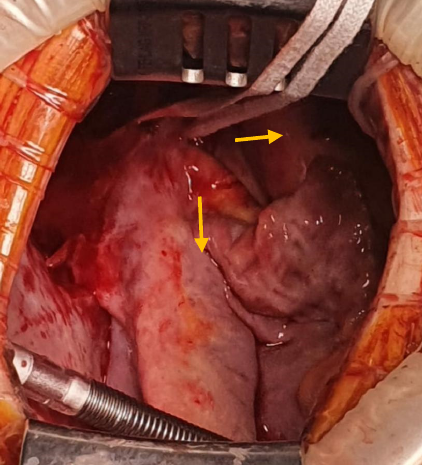
Figure 3. View of PAPVD in the SVC (pulmonary veins in the SVC—yellow arrow).